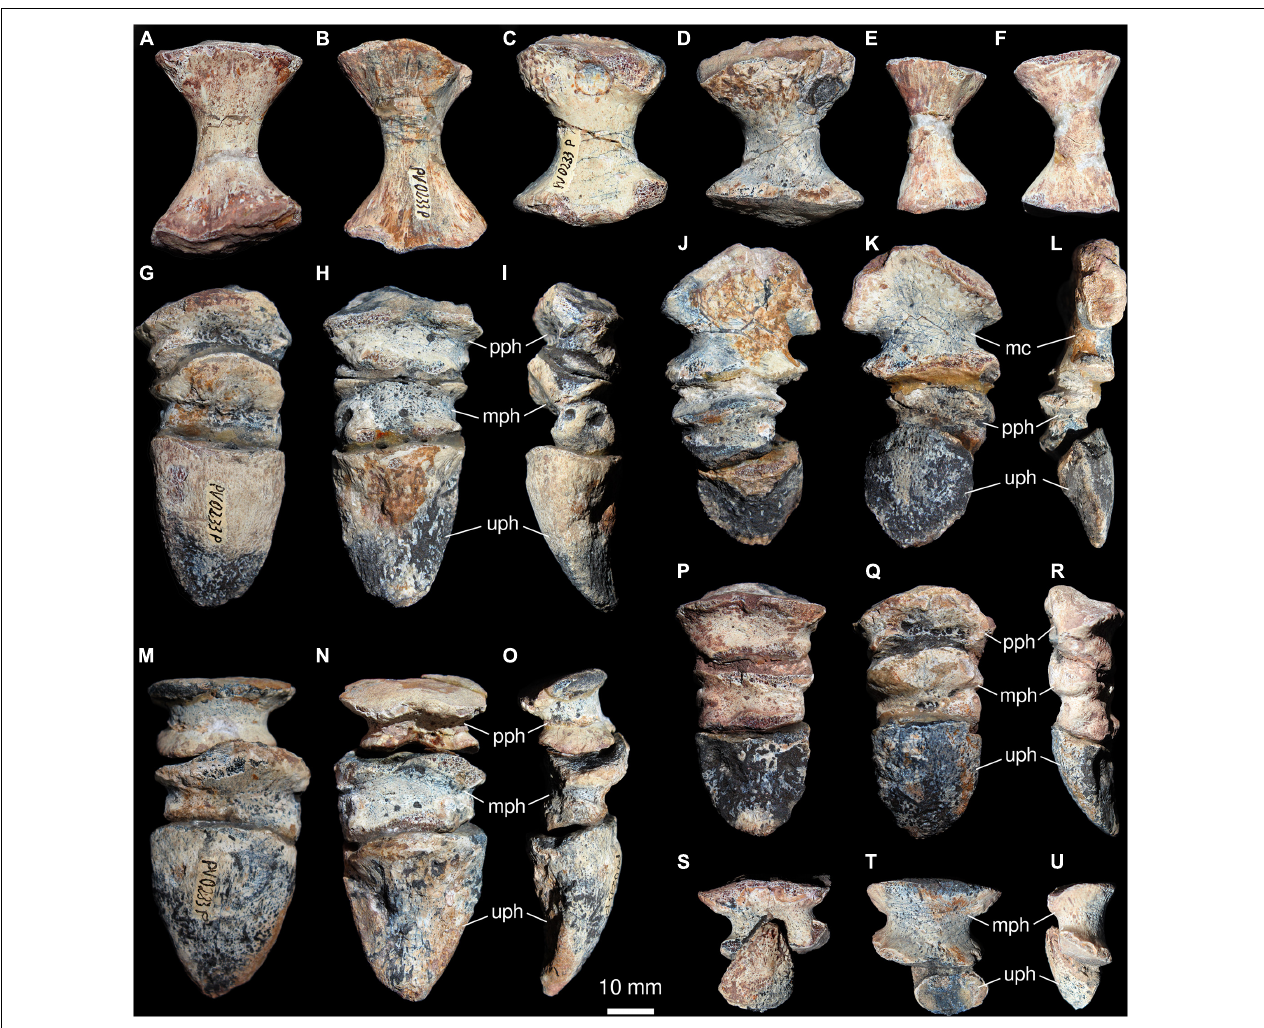
FIGURE 12 | Autopodial elements of Provelosaurus americanus (UFRGS-PV-0233-P). (A–F) Isolated metapodials in dorsal (A,C,E) and ventral (B,D,F) views. (G–U) Articulated elements in dorsal (G,M,Q,T) , ventral (H,J,N,P,S) , left lateral (I,R) and right lateral (L,O,U) views. (J–L) Pollex, composed of a metacarpal, a proximal/basal phalanx and a distal/ungual phalanx. mc, metacarpal; mph, middle phalanx; pph, proximal phalanx; uph, ungual